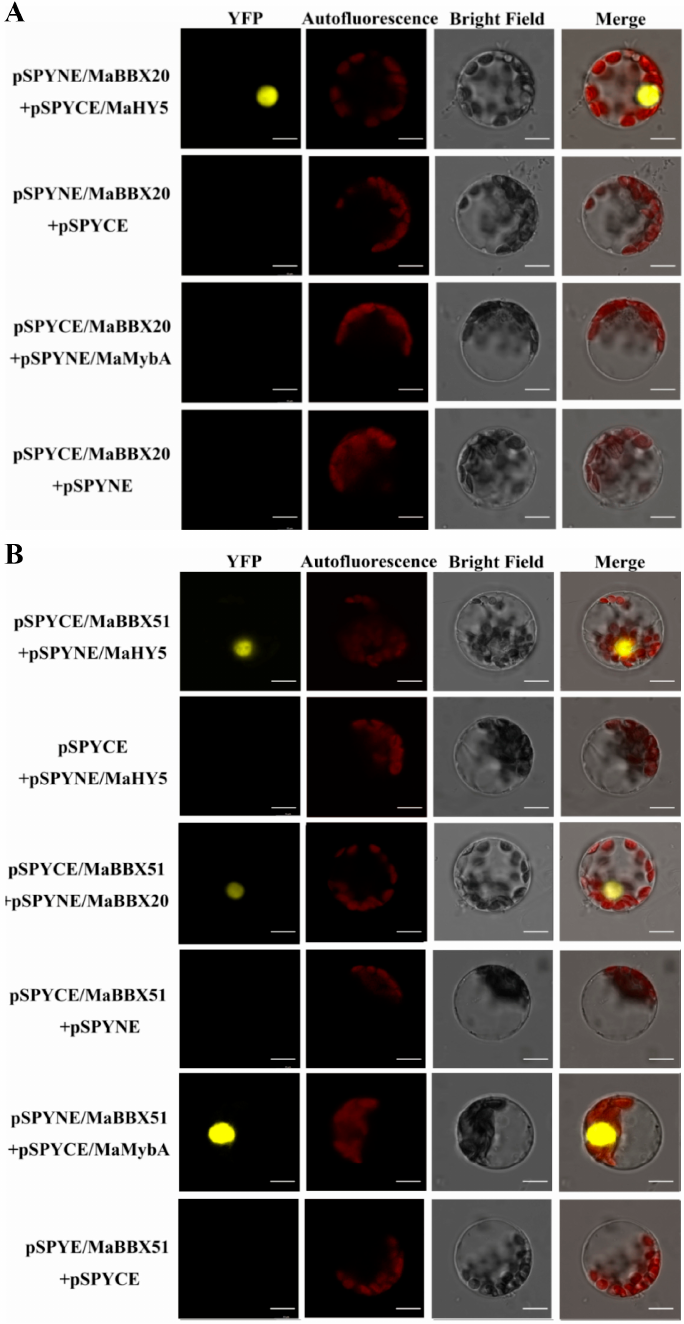
Figure 6. Interaction between MaBBX20, MaBBX51, and other anthocyanin-related proteins in Ara- bidopsis protoplasts. ( A ) A BiFC assay was carried out to verify the interaction between MaBBX20 and MaHY5 or MaMybA in Arabidopsis protoplasts. ( B ) BiFC assay showing MaBBX51 interacting with MaHY5, MaBBX20, and MaMybA. YFP: YFP fluorescence; Autofluorescence: chloroplast autoflu- orescence; Merge: merged images of chloroplast autofluorescence, YFP fluorescence, and bright-field microscopy. Scale bars: 10 µ